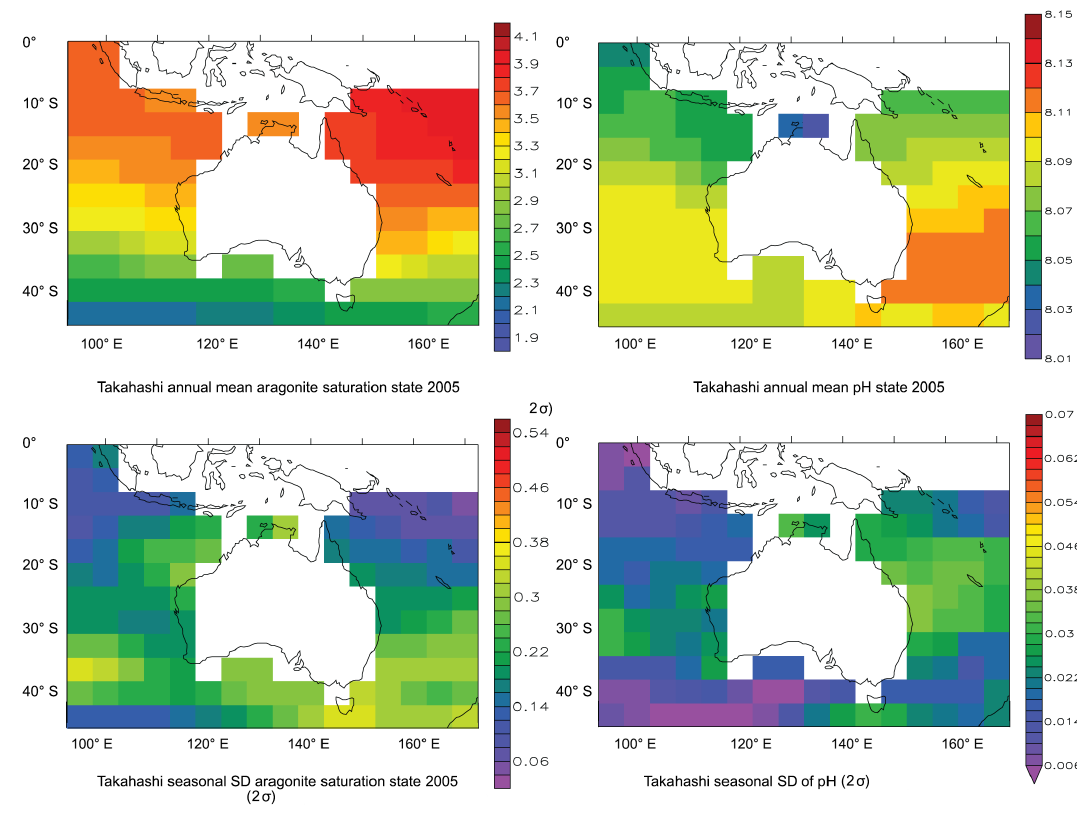
Figure 6. Upper: the annual mean aragonite saturation state and pH for 2005 from Takahashi et al. (2014). Lower: standard deviation (2 σ) of the seasonal variability in aragonite saturation state and pH for 2005 from Takahashi et al.